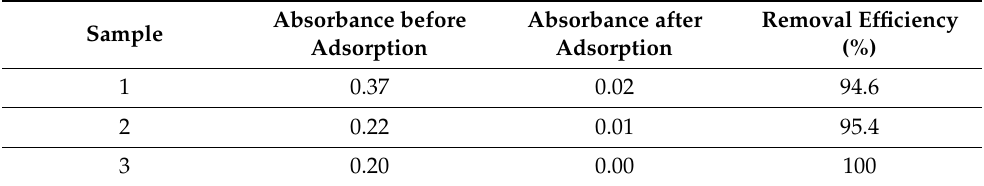
Table 2. Adsorption of nitrates to Fe 3 O 4 @AgNPs in real seawater